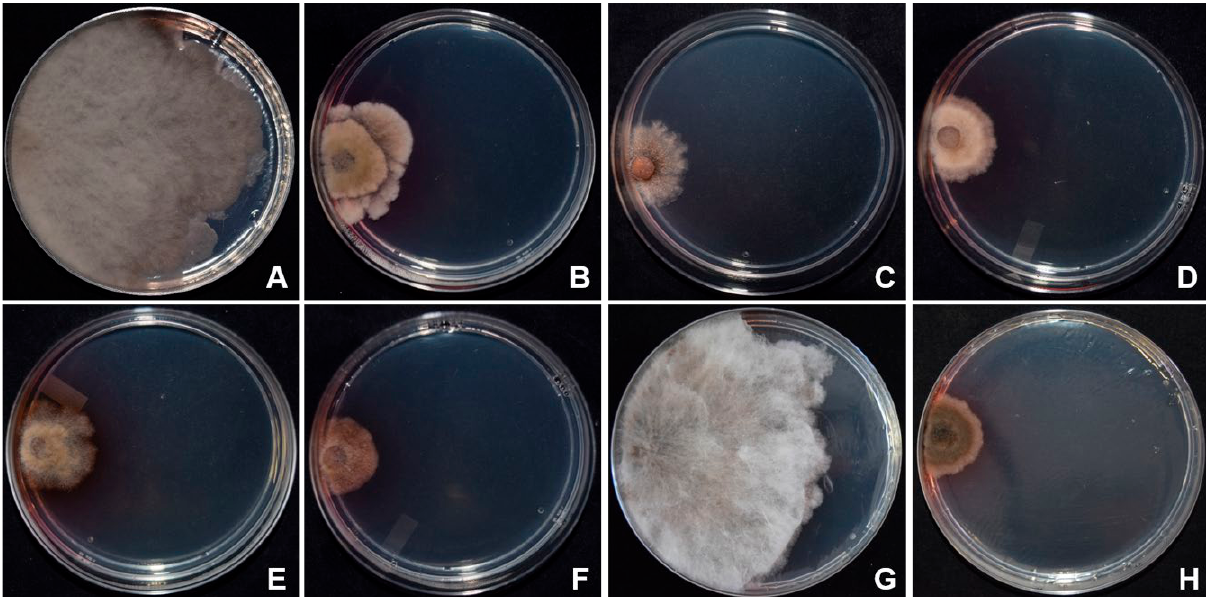
Figure 3. Growth of Lasiodiplodia gilanensis under oxidative stress. A) Control. B) PDA + 5% hydrogen peroxide (H 2 O 2 ). C) PDA + 15 μg mL -1 tropolone (Tp), DOPA-melanin inhibitor. D) PDA + H 2 O 2 + Tp. E) PDA + 500 μg mL -1 phthalide (Ph), DHN-melanin inhibitor. F)